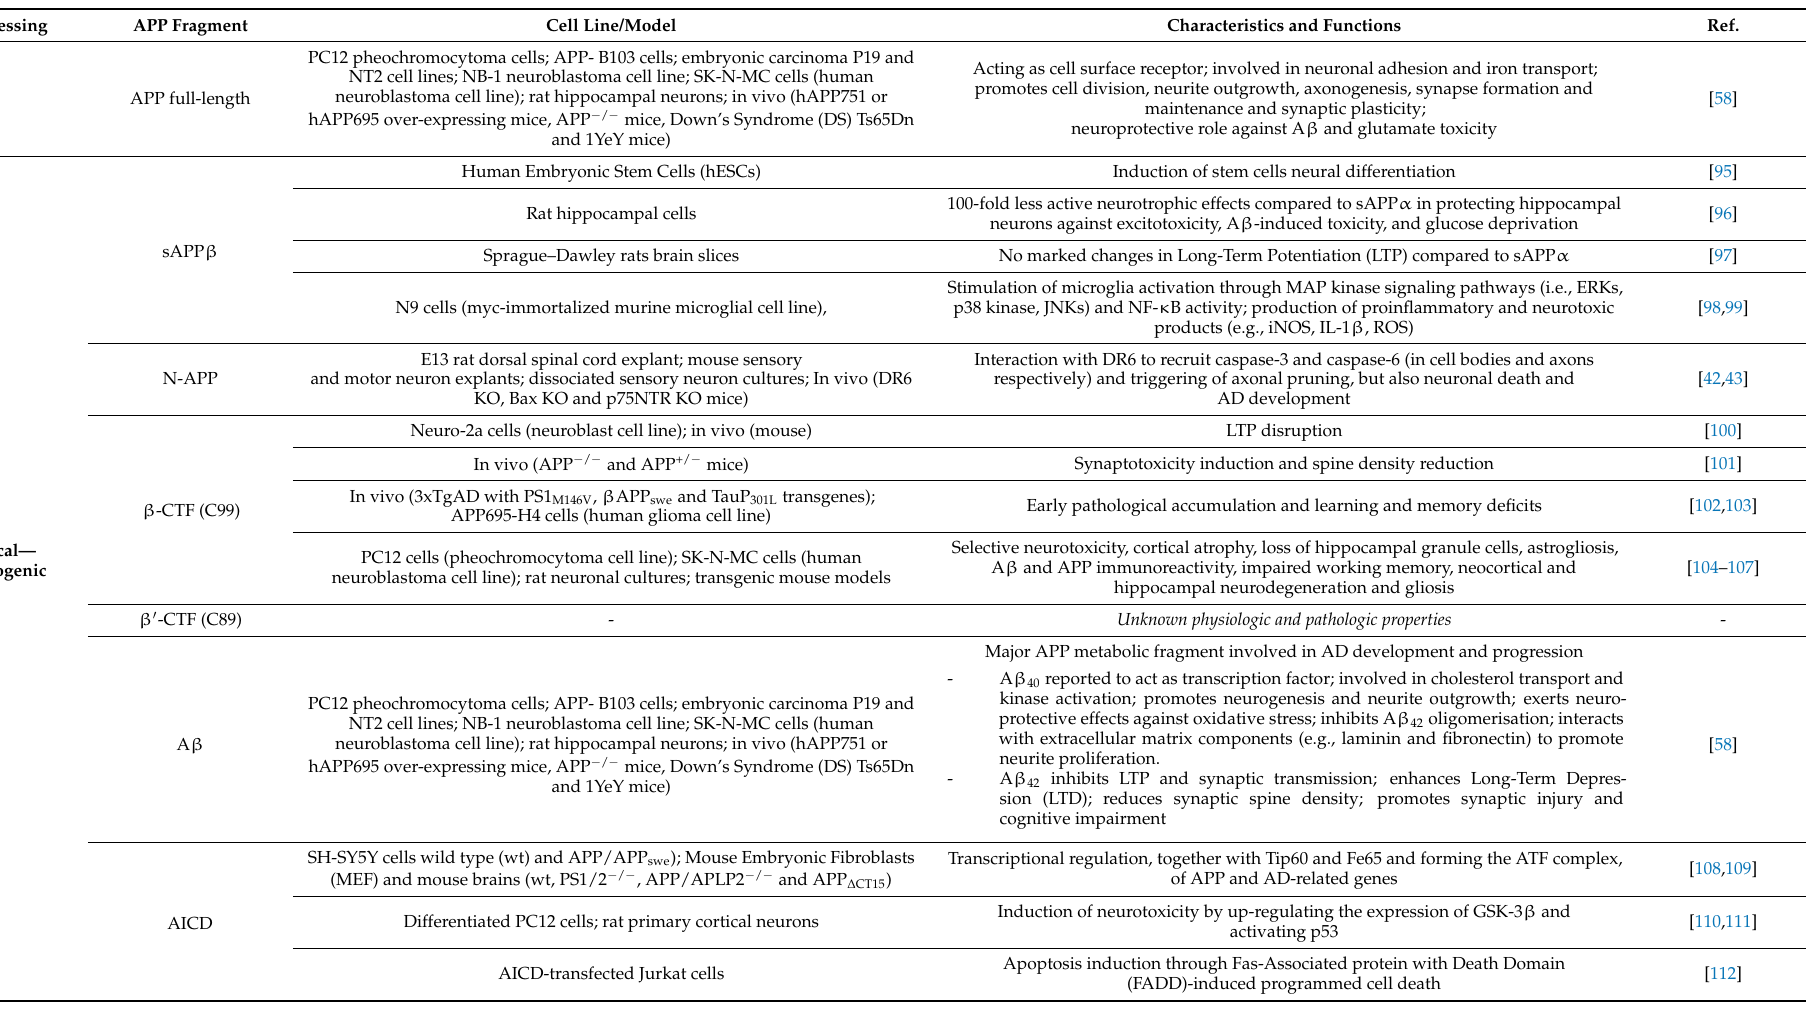
Table 1. APP proteolytic fragments and their reported